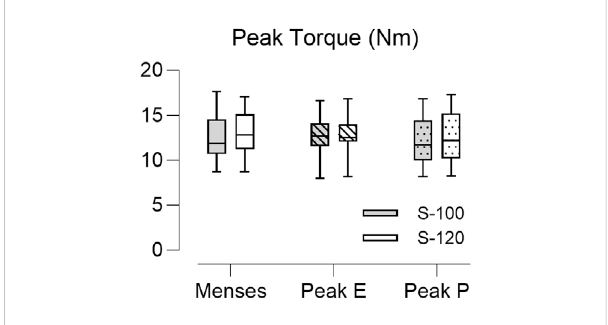
Boxplot ofthepeaktorque (PT)obtained from22 subjectsacross the three key time points in the menstrual cycle. Peak E indicates sessions at peak estradiol level and Peak P indicates sessions at peak progesterone level. The closed bar represents data obtained at maximum stimulus intensity (S-100) and the open bar represents data obtainedatsupramaximalstimulusintensity(S-120).Stimulusintensity and menstrual phase did not associate with PT values ( p = 0.664 and p = 0.481 respectively).